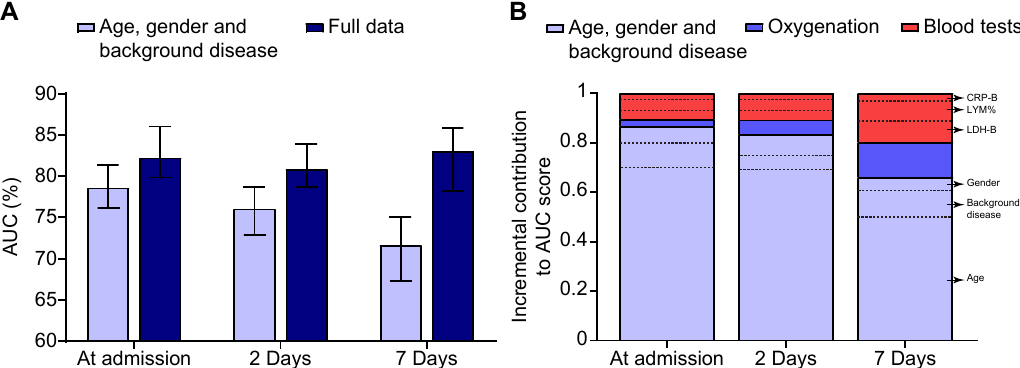
Figure 2. Predictive models’ performance. ( A ) Mean AUC of a model that utilizes data before hospital admission (i.e., age, gender, and background diseases) and of a model that utilizes data before and during hospitalization (i.e., includes the oxygenation score and blood biomarkers). AUC scores are presented for patients on the day of admission, two days post admission, and seven days post admission. ( B ) Sociodemographic and background disease, oxygenation, and blood test data and their sequential contribution to the “at admission”, “2-days” post admission and “7-days” post admission predictive